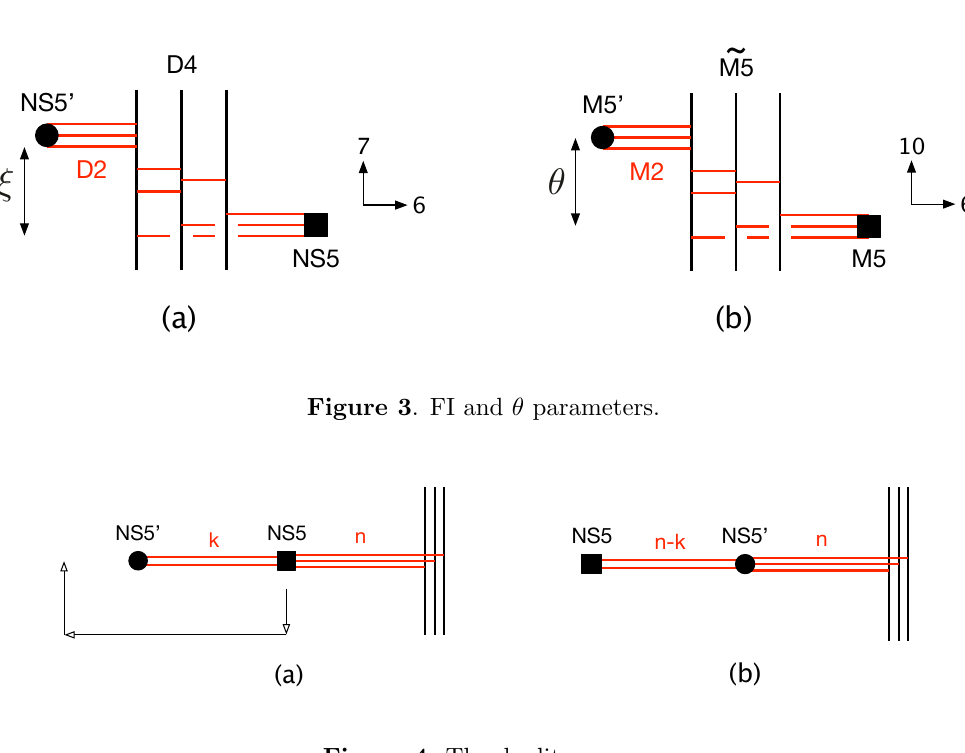
Figure 4 . The duality